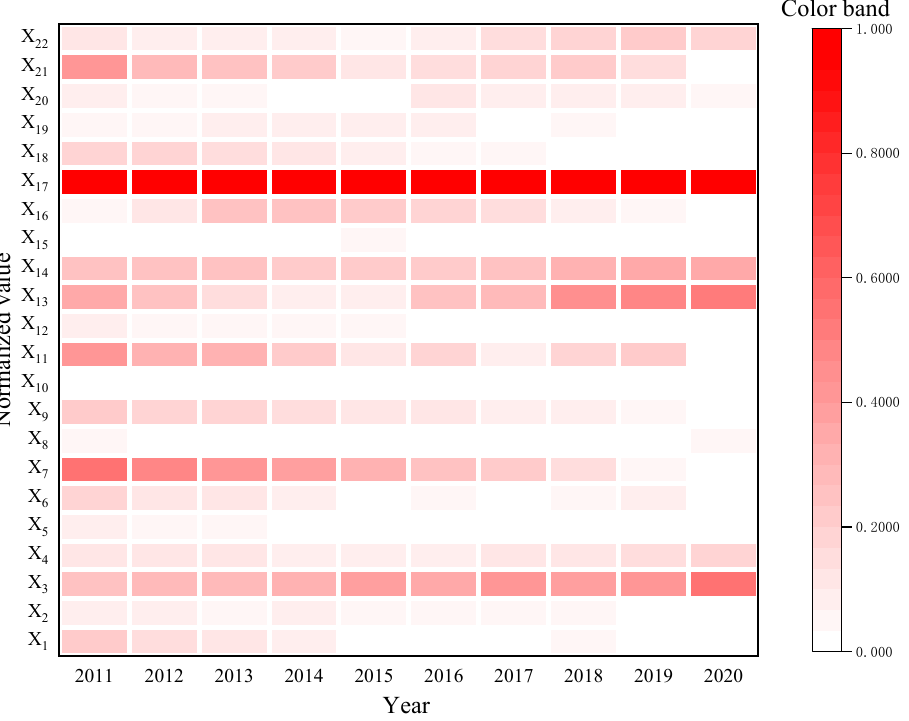
Figure 3. Heatmap of the obstacle degree of each index from 2011 to 2020.